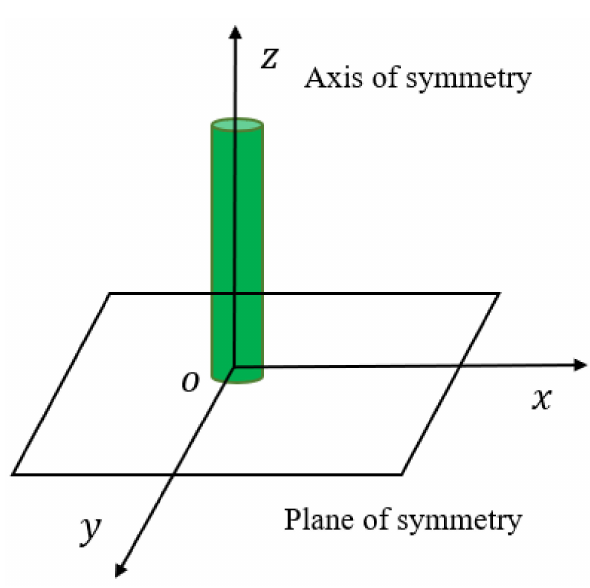
Figure 8. Elastic constitutive properties of